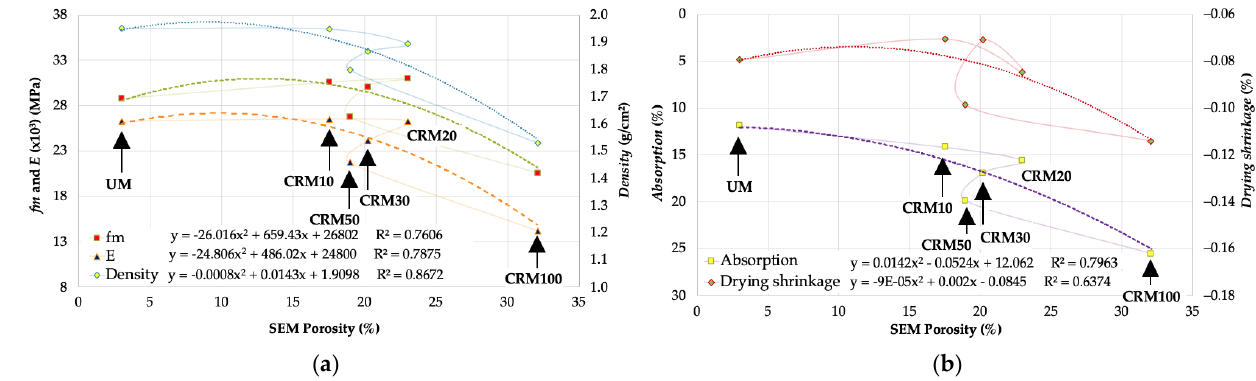
Figure 14. Correlation of Porosity by SEM and: ( a ) fm , E and density ; ( b ) absorption and drying shrinkage .